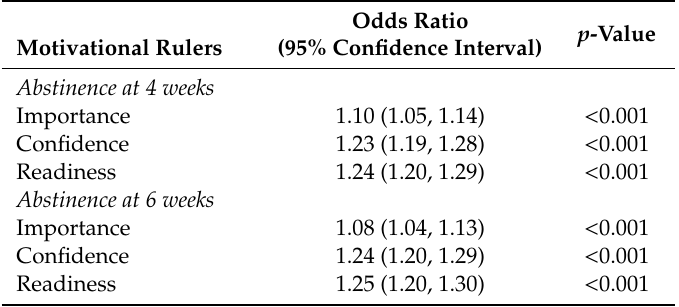
Table 5. Adjusted odds ratios and 95% Confidence Intervals from the logistic regression models for the motivational rulers a ff ecting smoking